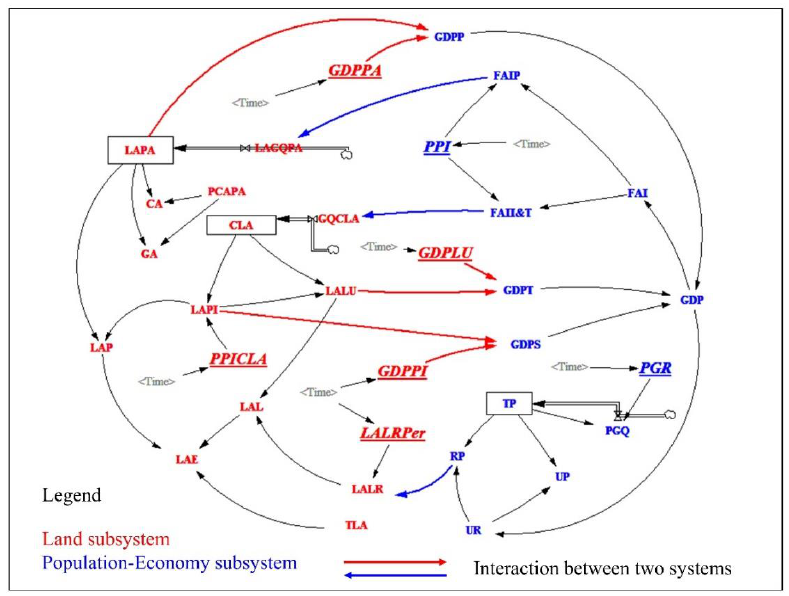
Figure 4. Interrelationship diagram of the PLE system dynamics model. Variables in underlined italics are control variables. Table 3. Driving factors and data